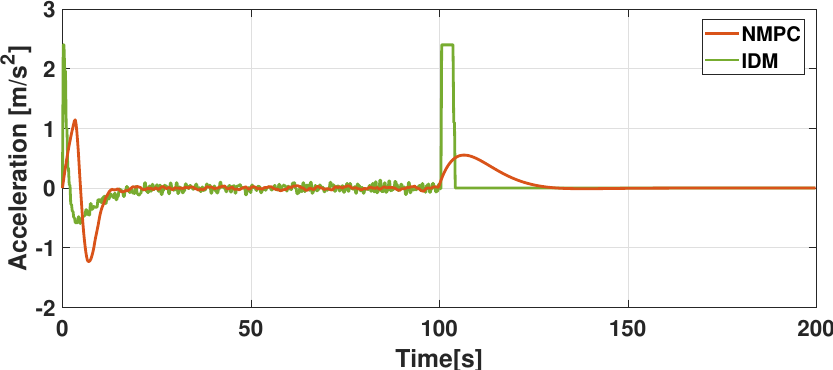
Figure 6. Single lane changing scenario . Performance of the proposed solution and comparison analysis w.r.t. IDM solution. Time-history of the ego vehicle acceleration a ( t )